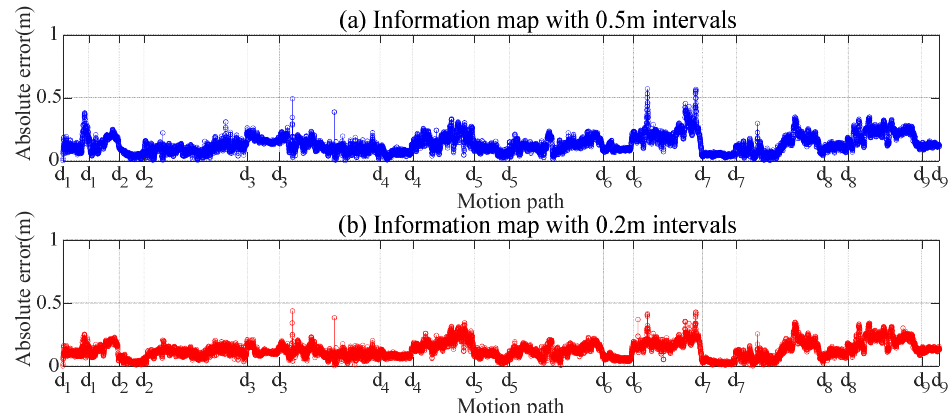
Figure 25. Experiment 3 error of the Map-AREKF algorithm when selecting information maps with different intervals.